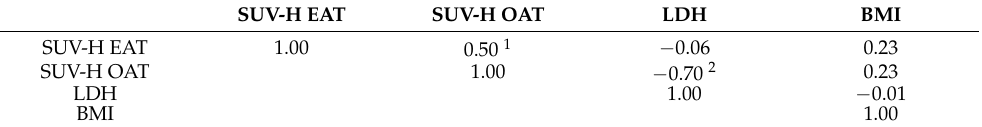
Table 4. Pearson’s correlation analysis of delta SUV-H EAT and OAT volumes, LDH levels, and BMI.